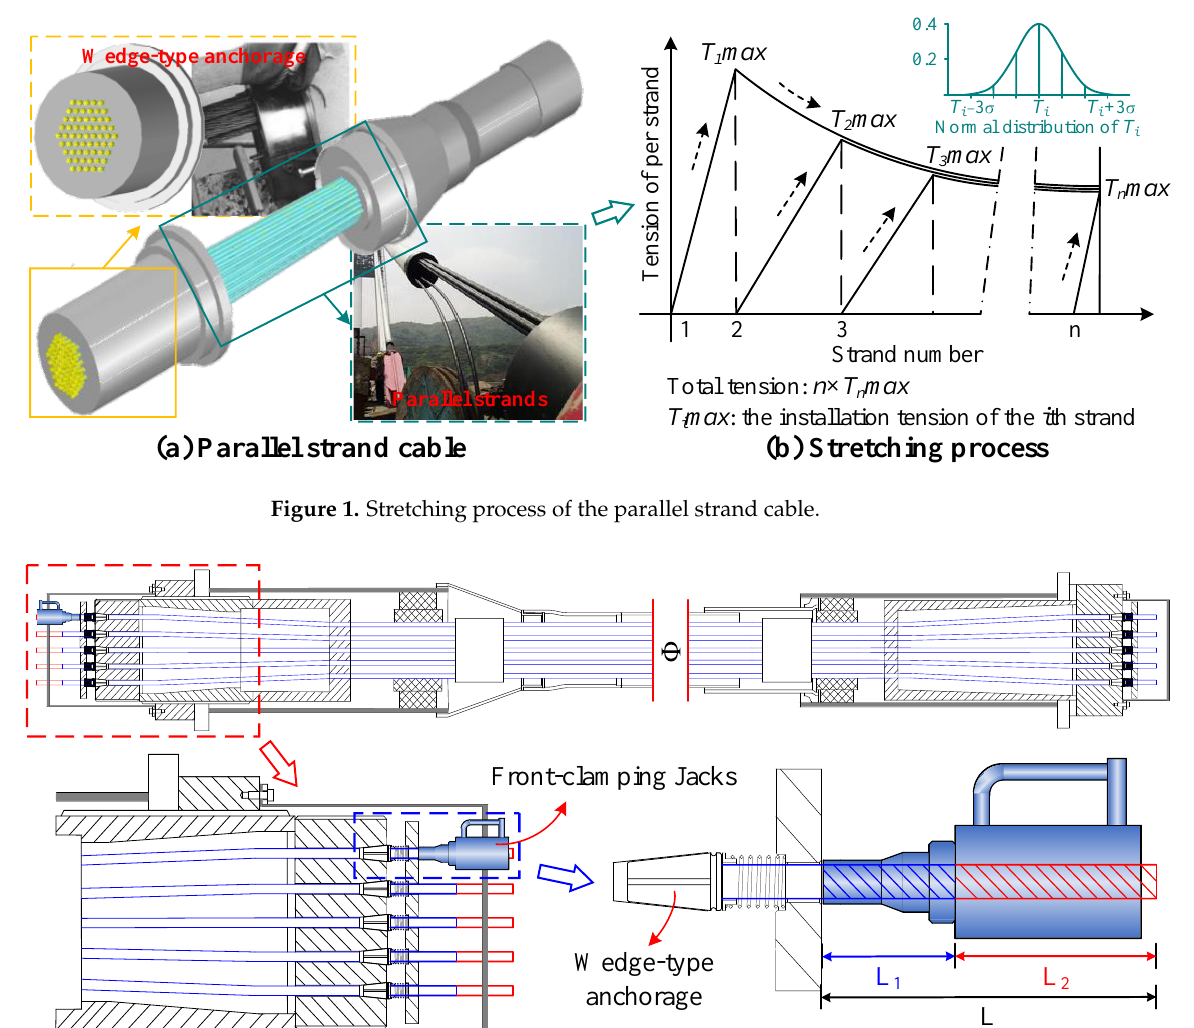
Figure 1. Stretching process of the parallel strand cable.